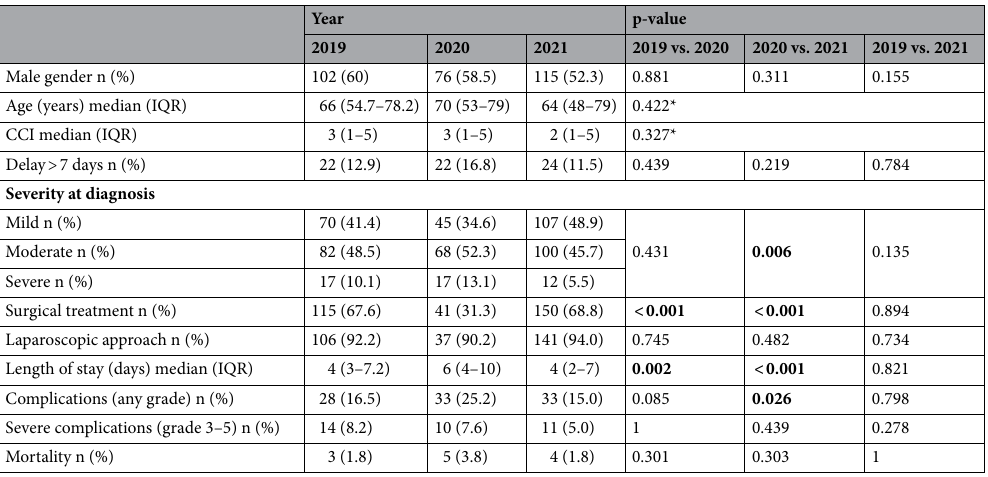
Table 3. Cholecystitis patients characteristics. CCI Charlson Comorbidity Index. *Non-significant p-value in Kruskal–Wallis test, therefore no multiple comparations were